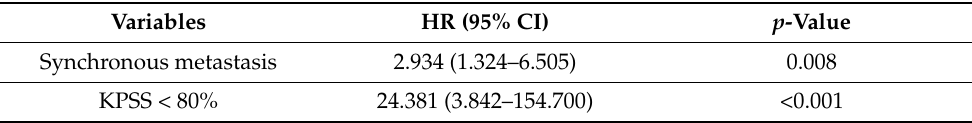
Figure 1. ( A ): Prognostic factors negatively influencing Overall Survival (OS) at univariate analysis: presence of multiple lung metastases. ( B ): Prognostic factors negatively influencing OS at univariate analysis: dimensions of lung metasta- sis ≥ 3 cm. ( C ): Prognostic factors negatively influencing OS at univariate analysis: lung metastasis synchronous with primary renal cancer. ( D ): Prognostic factors negatively influencing OS at univariate analysis: Karnofsky Performance Status Scale (KPSS) < 80%. Table 2. Multivariate Cox regression analysis for negative prognostic factors for OS.